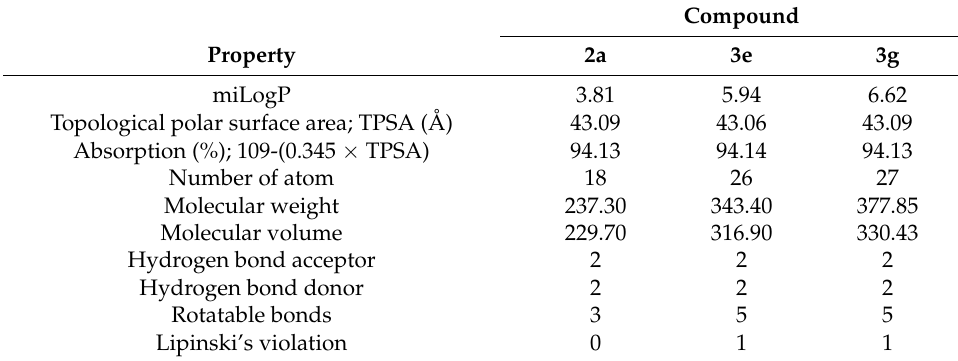
Figure 6. The interaction between the most ( 2a , 3e and 3g ) and the least ( 2b and 3b ) active compounds against α -amylase. Table 4. Pharmacokinetics properties predictions of compounds 2a , 3e and 3g .